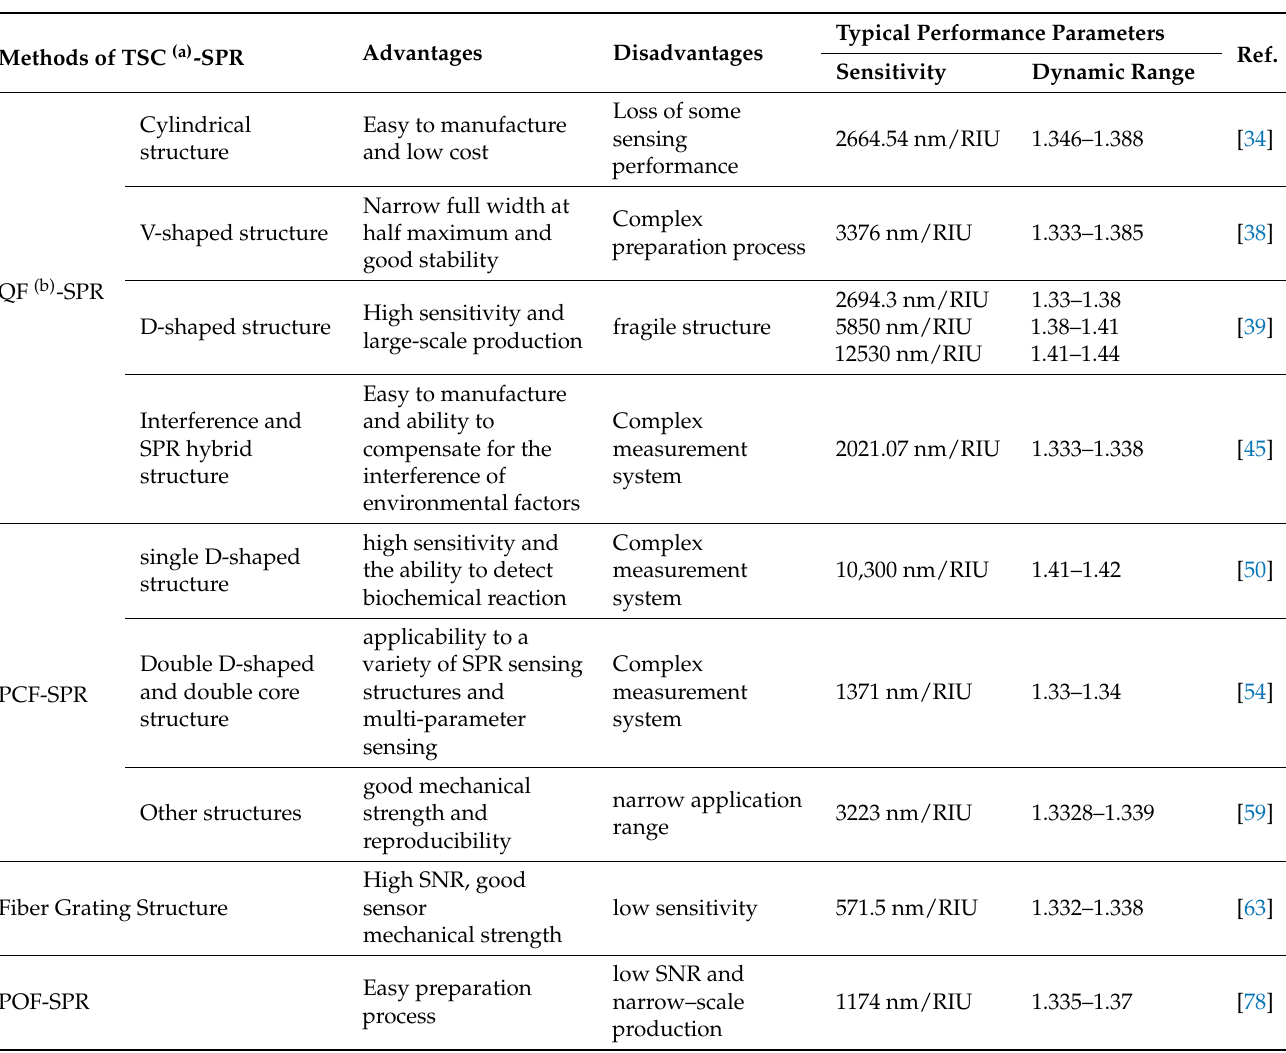
Table 1. The advantages and disadvantages of the realization methods of TSC-SPR fiber